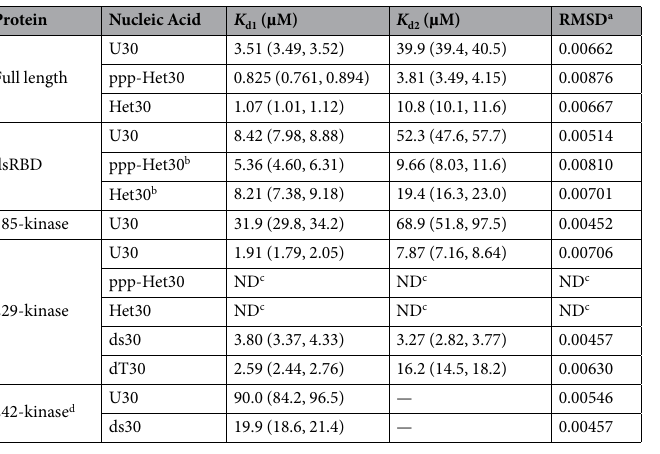
Table 1. Sedimentation velocity analysis of PKR constructs binding to RNA. Parameters obtained by global nonlinear least square analysis of the sedimentation velocity data using a model of sequential binding of two proteins monomers. The values in parentheses represent the 95% joint confidence intervals obtained using the F-statistic. a Root mean square deviation in absorbance units. b Good fits required that the sedimentation coefficients for the protein-RNA complexes be allowed to float to their best-fit values. c Not determined. More than two protein monomers bind to the RNA and the data could not be reliably fit to an association model. Plots of the normalized g^(s * ) distributions for these experiments are in Fig. S3. d 242-kinase data were fit to a 1:1 binding